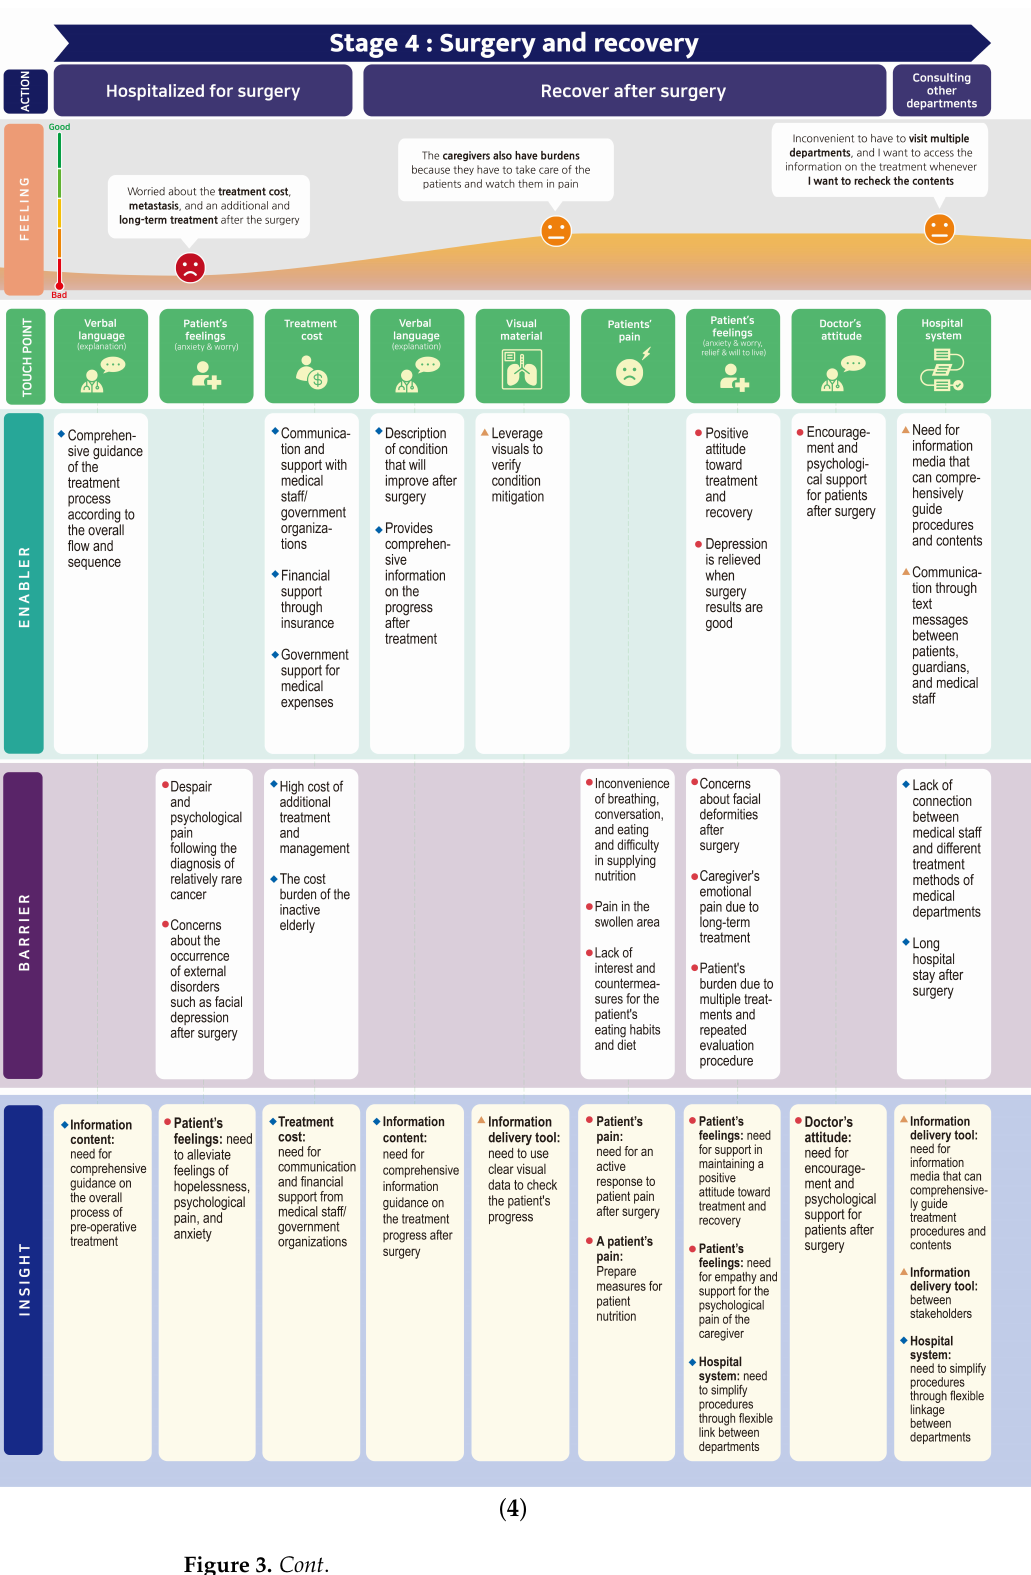
Figure 5. This is a wide figure. Figure 3. Cont